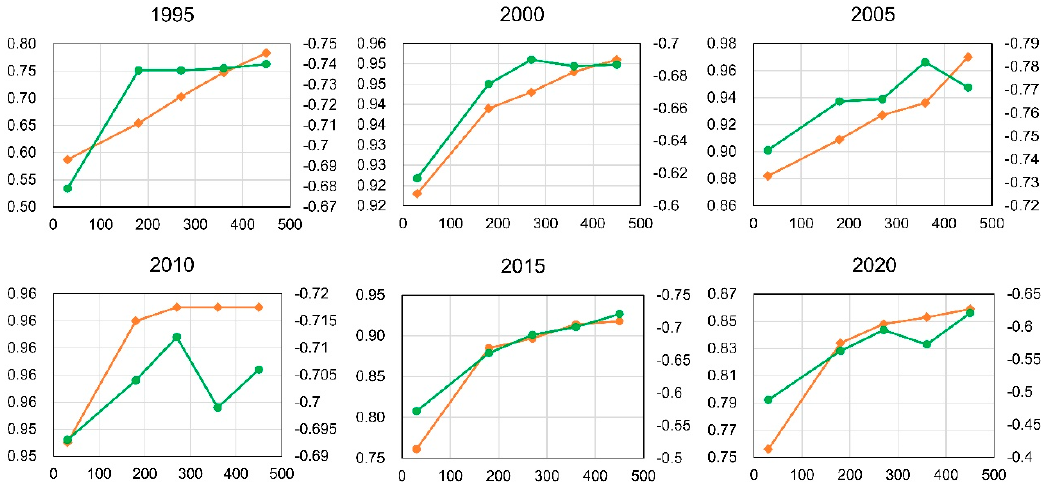
Figure 6. Correlation between NDISI and NDVI and mean LST across grid cell sizes. All correlations were significant at the 0.01 level (2-tailed). The orange and green lines represent NDISI and NDVI, respectively.